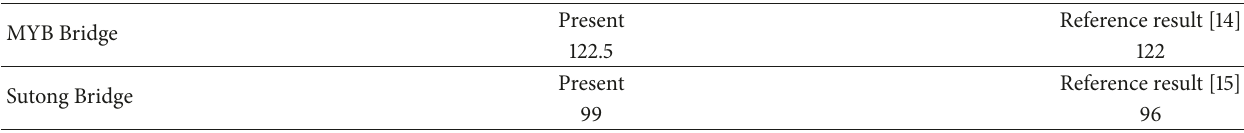
Table 1: Comparison of critical aerostatic velocity (m ⋅ s −1